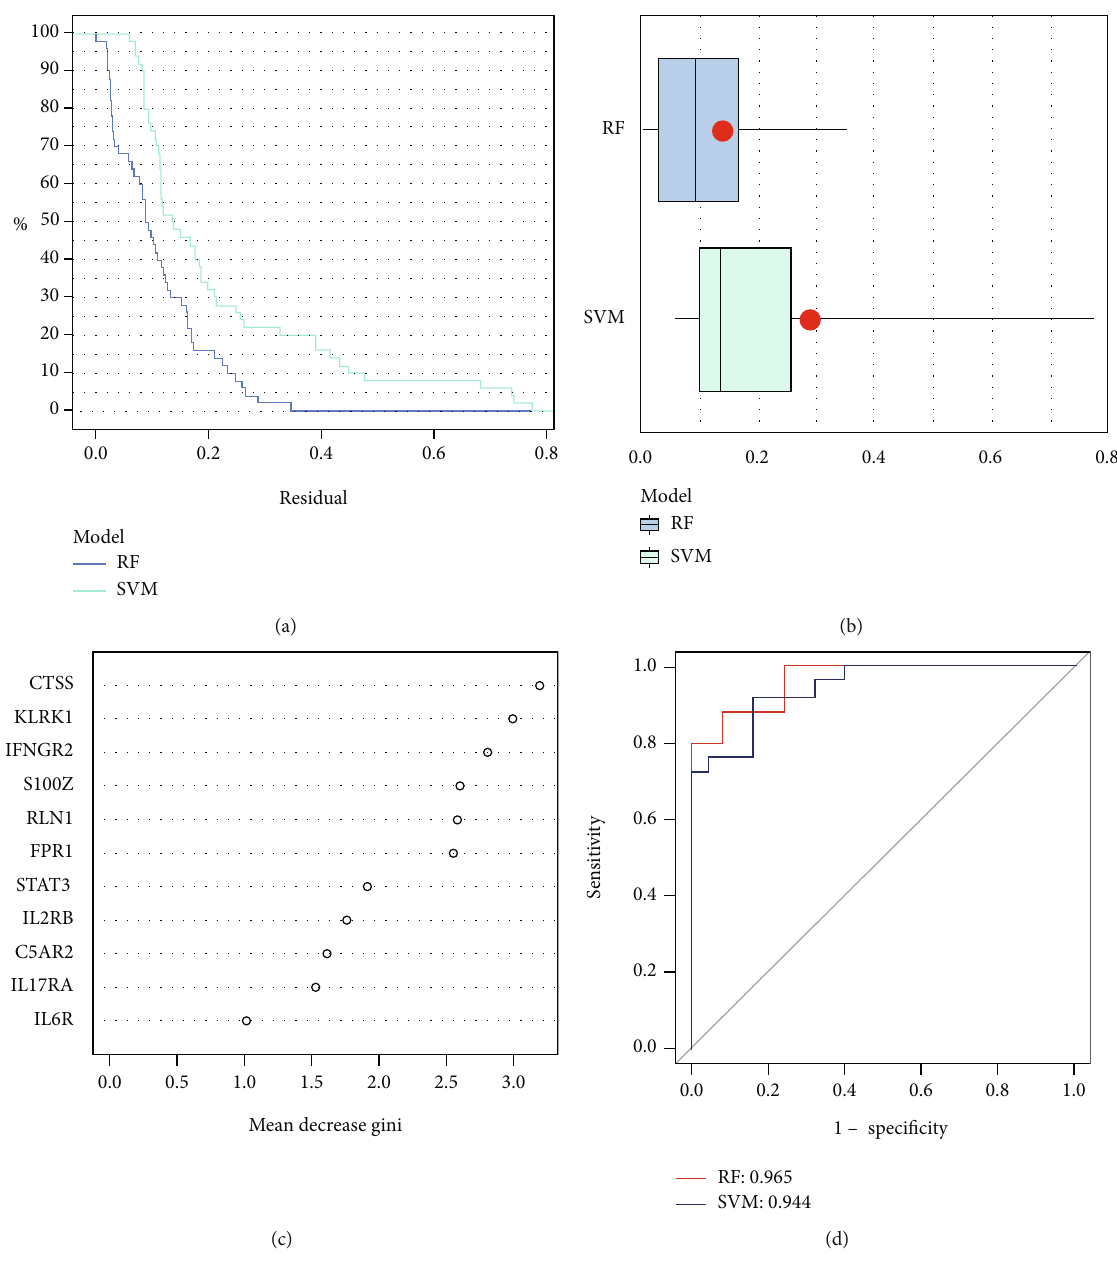
Figure 3: (a) Reverse cumulative distribution of residual. (b) Boxplots of residual. (c) 11 IRGs were visualized after ranking genes based on importance, and six IRGs (including FPR1, RLN1, S100Z, IFNGR2, KLRK1, and CTSS) with importance scores greater than 2. (d) The AUC value of the ROC curve indicated that the RF model (0.965) has higher accuracy than the SVM model